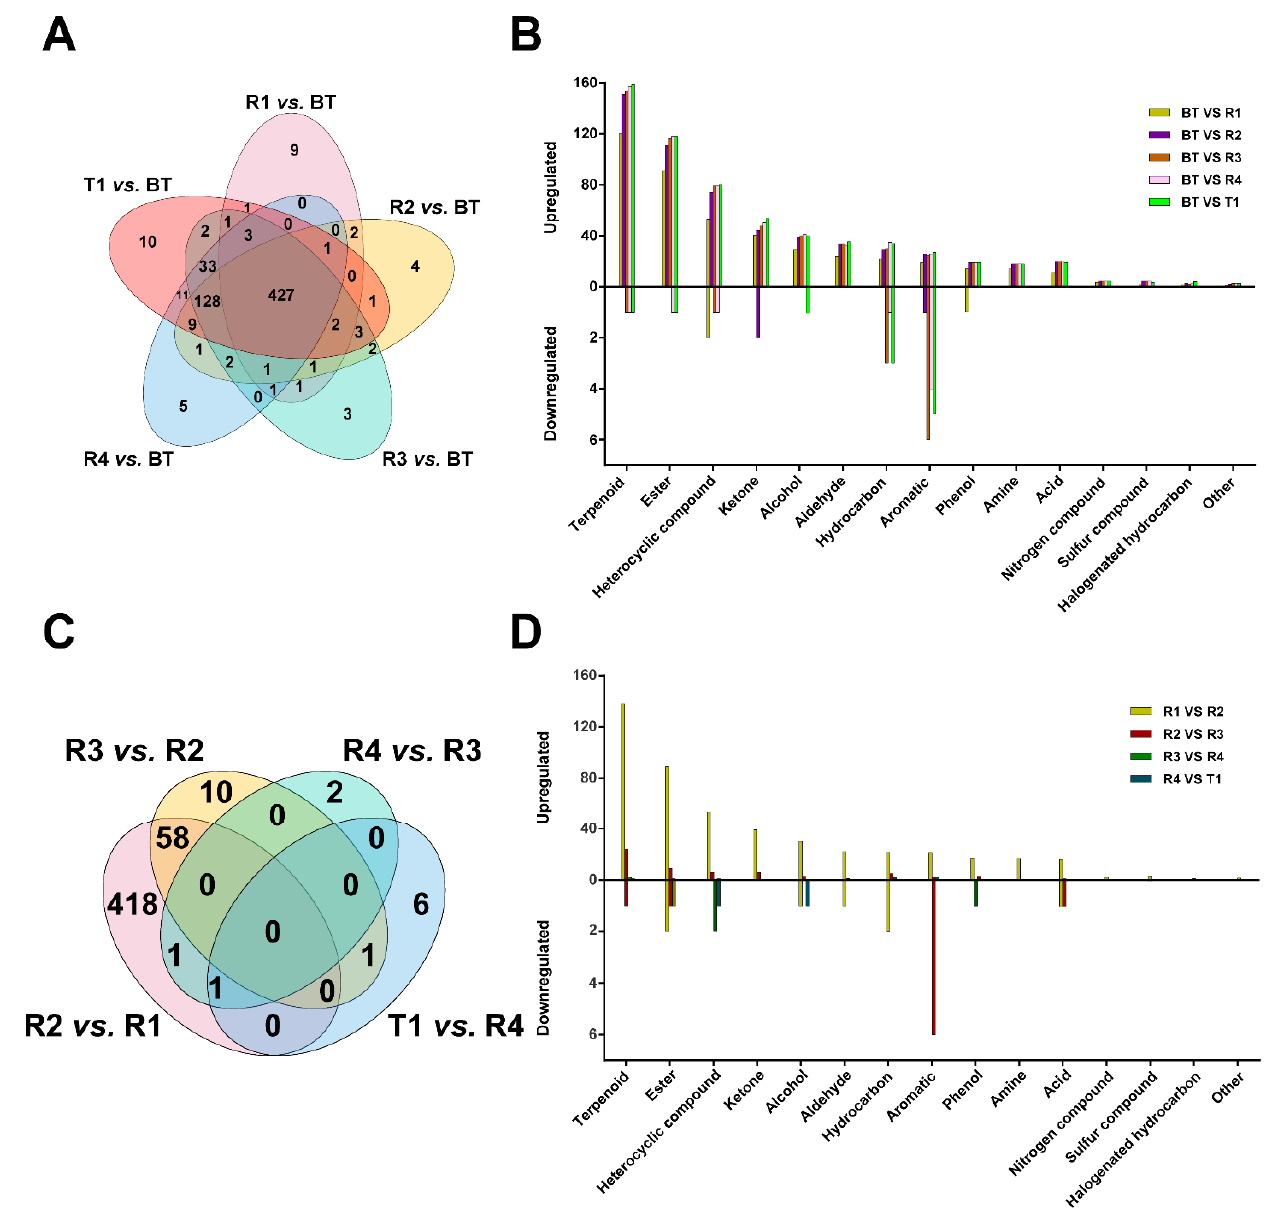
Figure 4. Differential volatile organic compounds (VOCs) in the six tea samples. ( A ) Venn diagram of the differential VOCs of R1 vs. BT, R2 vs. BT, R3 vs. BT, R4 vs. BT, T1 vs. BT; ( B ) Chemical classification of differential VOCs within the five pairwise comparisons; ( C ) Venn diagram of the differential VOCs of R2 vs. R1, R3 vs. R2, R4 vs. R3, T1 vs. R4; ( D ) Chemical classification of differential VOCs within the four pairwise comparisons. BT: base tea; R1, R2, R3, R4: jasmine tea with one (R1), two (R2), three (R3), and four (R4) rounds of scenting processes; T1: jasmine tea with four rounds of scenting processes and the Tihua process.